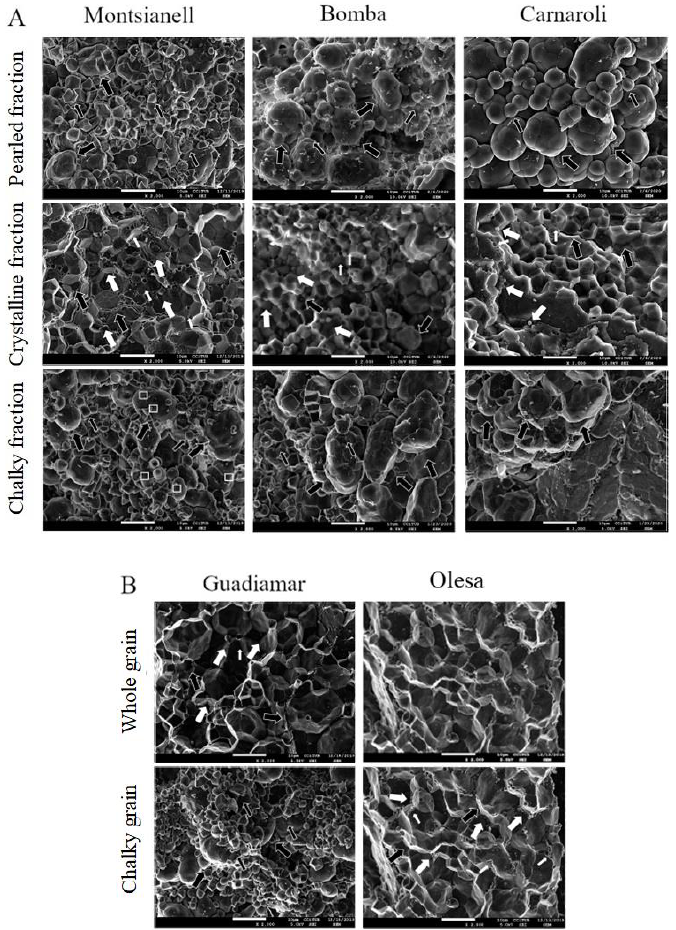
Figure 3. ( A ). SEM images of sections of the pearl fraction and the chalky fraction from the normal perfect grain, and sections of the chalky grain of each pearled cultivar. ( B ). SEM images of sections of the normal perfect grain and sections of the chalky grain of each crystalline cultivar. Large black arrows point to amyloplasts, small black arrows point to free starch granules, large white arrows point to protein bodies and small white arrows point to traces of protein bodies. White squares enclose micropores derived from α amylase attacks. The appearance of the crystalline parts of the pearled grains was similar to the non- pearled (crystalline) cultivars Guadiamar and Olesa, with the polyhedral starch granules perfectly arranged inside the amyloplasts and surrounded by protein bodies or the space artefacts left behind as a consequence of their loss during sectioning. The chalky grains of both crystalline cultivars appeared the same as the chalky grains from the pearled culti- vars.